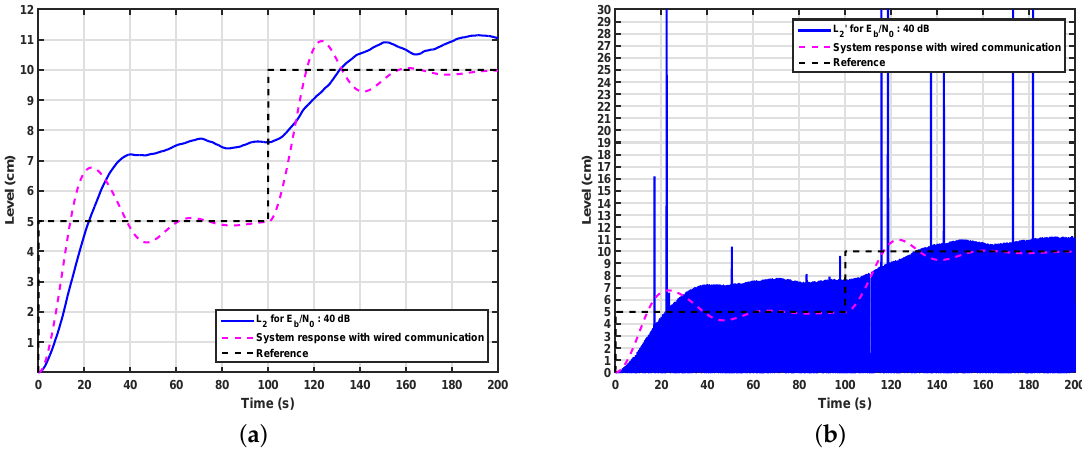
Figure 9. ( a ) System response without wavelet coding for various signal-to-noise ratios; ( b ) signal received by the controller on a system without wavelet